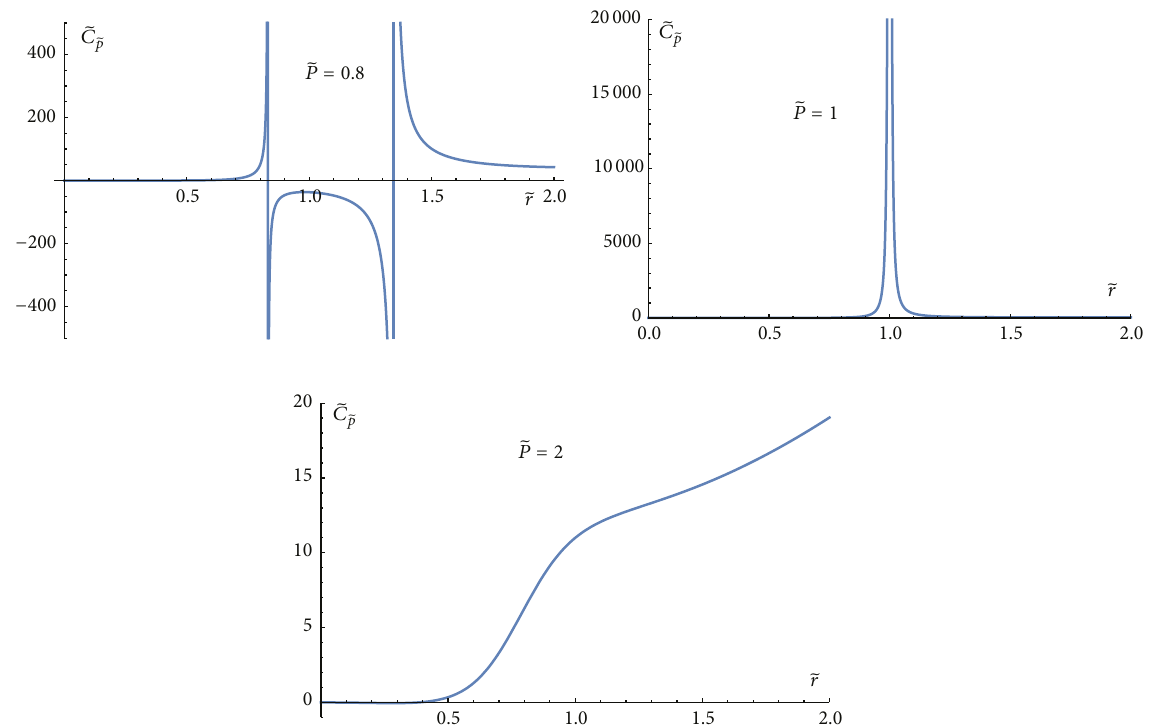
̃𝑃 = 1 = ̃𝑃 𝑐 which has only one divergent point and